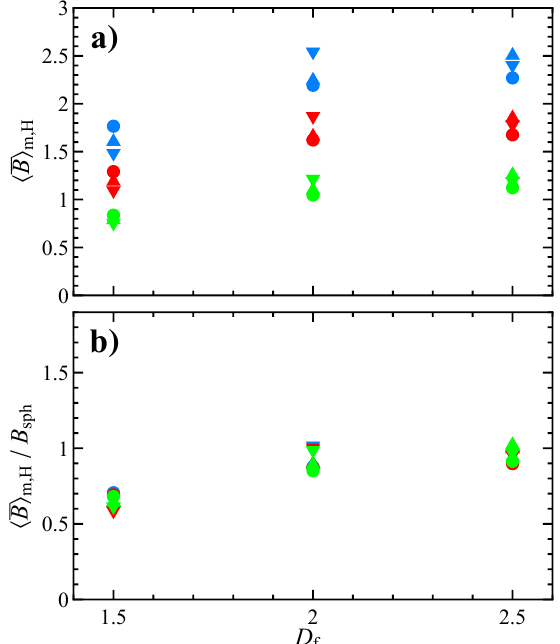
Figure 9. ( a ) Ensemble-average intrinsic viscosity normalized with the aggregate hydrodynamic radius as in Equation (23). ( b ) Same data as panel a normalized by the intrinsic viscosity of a sphere in a power-law fluid. In both panels, the symbols denote the number of primary particles composing the aggregate (lower triangle N p = 50, upper triangle N p = 20, and circle N p = 10) and the colors refer to the flow index (blue n = 1.0, red n = 0.7, and green n =